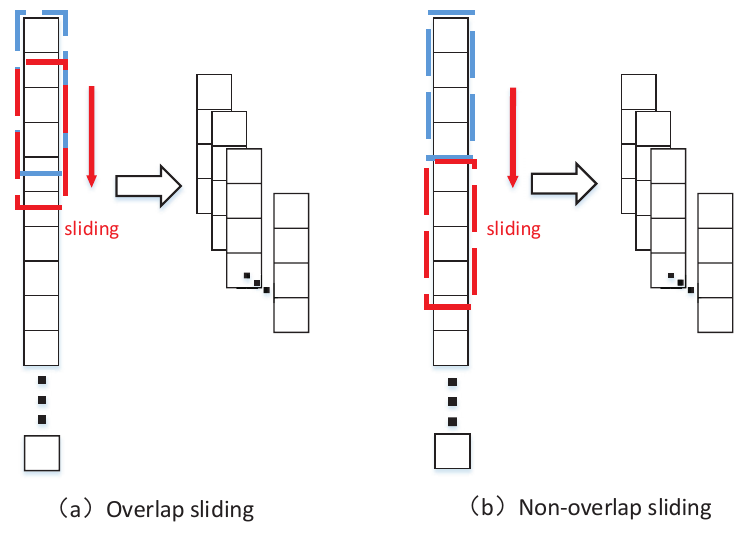
Figure 6. Sliding